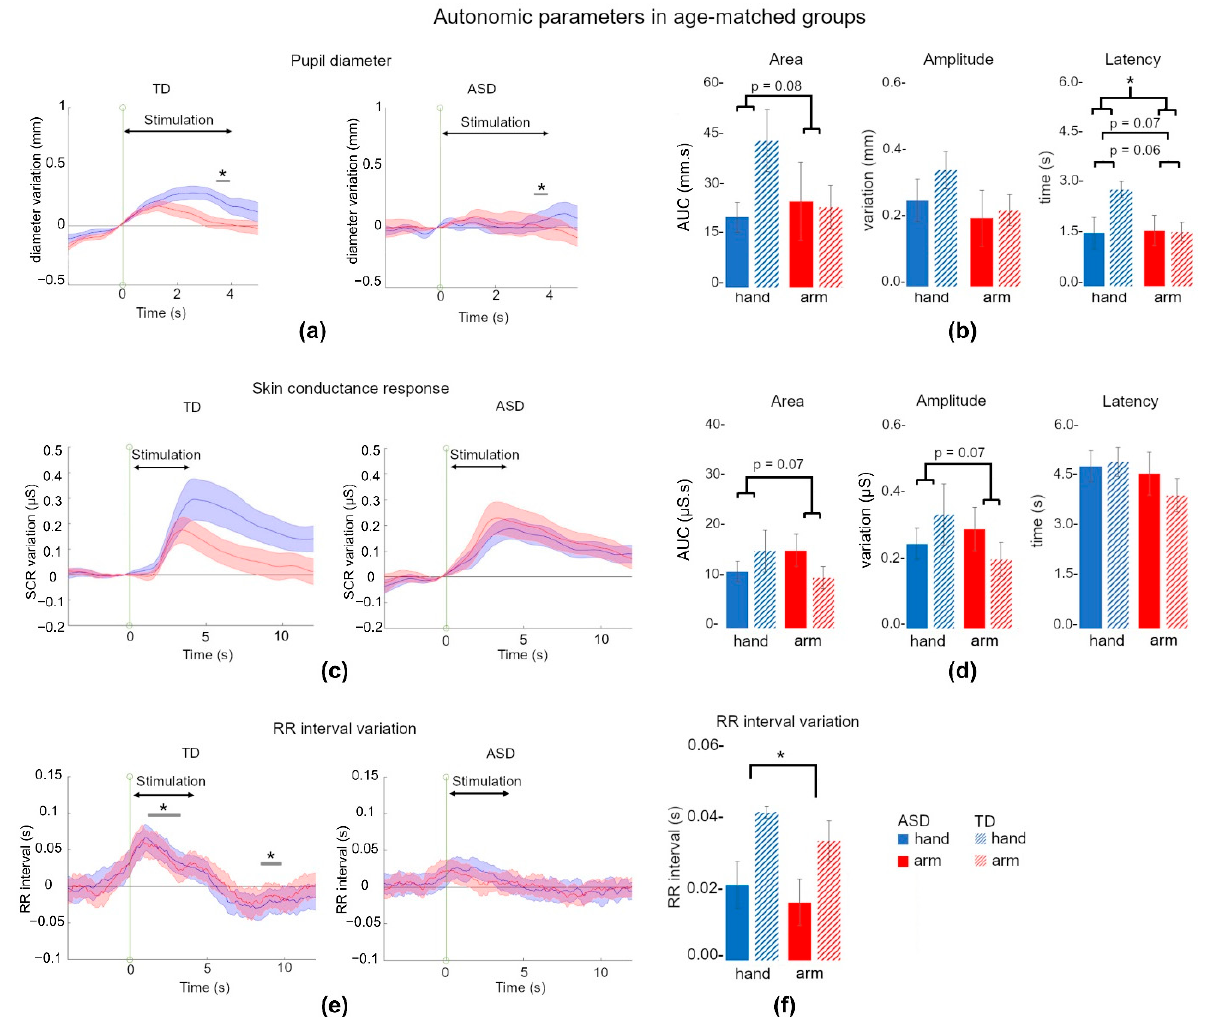
Figure 3. ANS responses to tactile stimulation in ASD and age-matched TD groups. ( a ) Mean pupil dilation (relative to the baseline value, in mm) as a function of time during an arm stimulation (red) or a hand stimulation (blue), in TD and ASD groups. The shading around the curve corresponds to the SEM. The green vertical line (0 s) indicates the beginning of the stimulation. The continuous black line indicates the length of the stimulation. The continuous grey line indicates the significant difference between the two curves. ( b ) Mean values ( ± standard error) for the three pupil parameters extracted for the two stimulation conditions (arm in red, hand in blue): AUC (in mm.s), maximum amplitude (in mm), and latency of the maximum response (in s). TD are represented with hatched columns (right columns), ASD with filled columns (left columns). ( c ) Mean SCR (relative to the baseline value, in µ S) as a function of time during an arm stimulation (red) or a hand stimulation (blue), in TD and ASD groups. Same conventions as in ( a ). ( d ) Mean values ( ± standard error) for the three skin conductance parameters calculated for the two conditions (arm in red, hand in blue): AUC (in µ S.s), maximum amplitude (in µ S), and latency of the SCR (in s). Same conventions as in ( b ). ( e ) Mean RR interval (relative to the baseline value, in s) as a function of time during an arm stimulation (red) or a hand stimulation (blue), in TD and ASD groups. The shading around the curve corresponds to the SEM. Same conventions as in ( a ). ( f ) Mean value ( ± standard error) of the RR interval variation (in s) calculated for the two conditions (arm in red, hand in blue) and for the two groups. Same conventions as in b. *: p < 0.05. p values for tendencies are